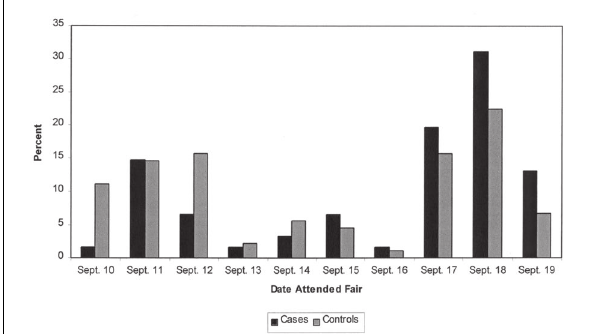
Figure 2) Rates of illness by date of attending the fair, September (Sept) 1999. The numbers above the bars indicate the number of cases who visited the agriculture pavilion each